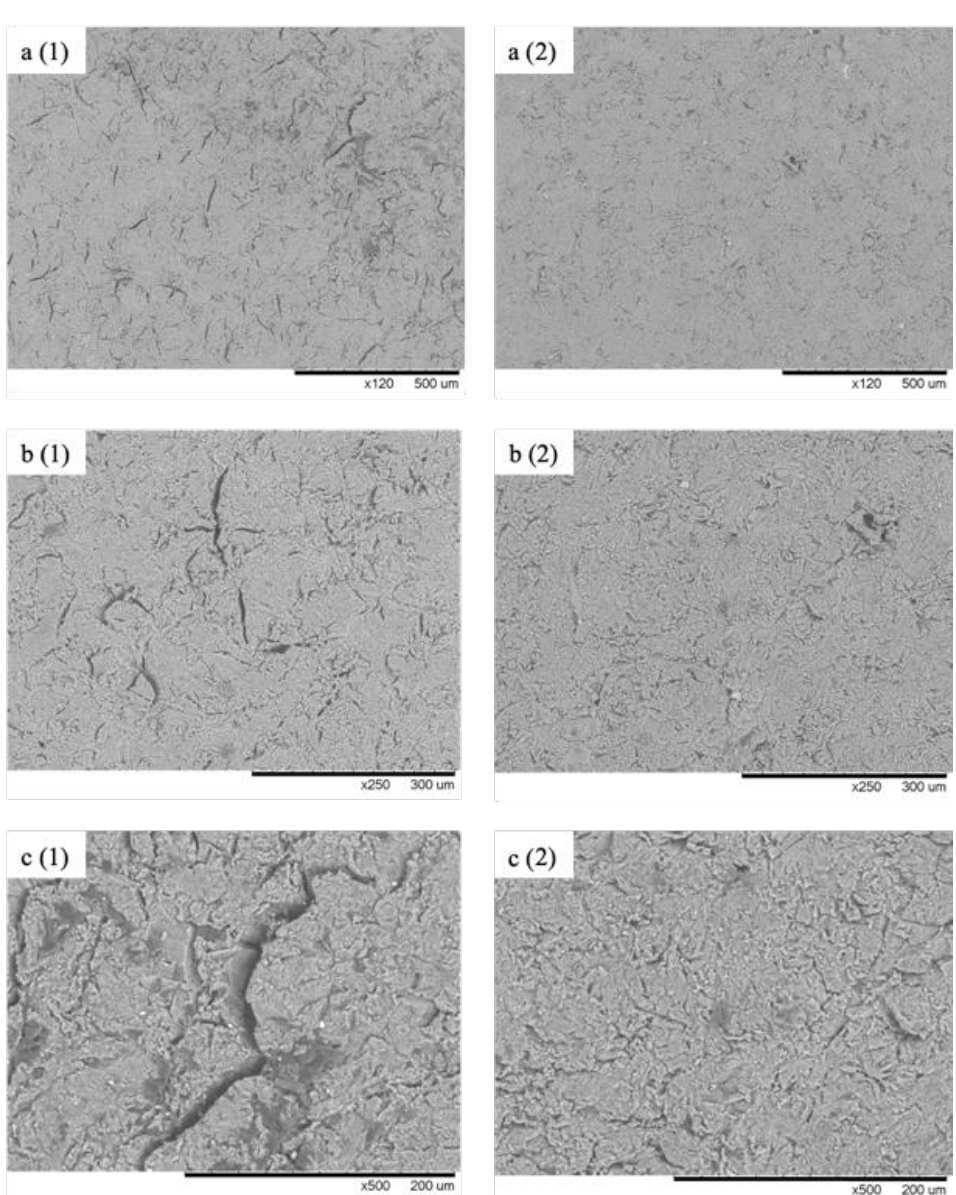
Figure 6. SEM micrographs of the new and aged Viton sample. ( a ) ×120, ( b ) ×250, ( c ) ×500 magnifi- cation.